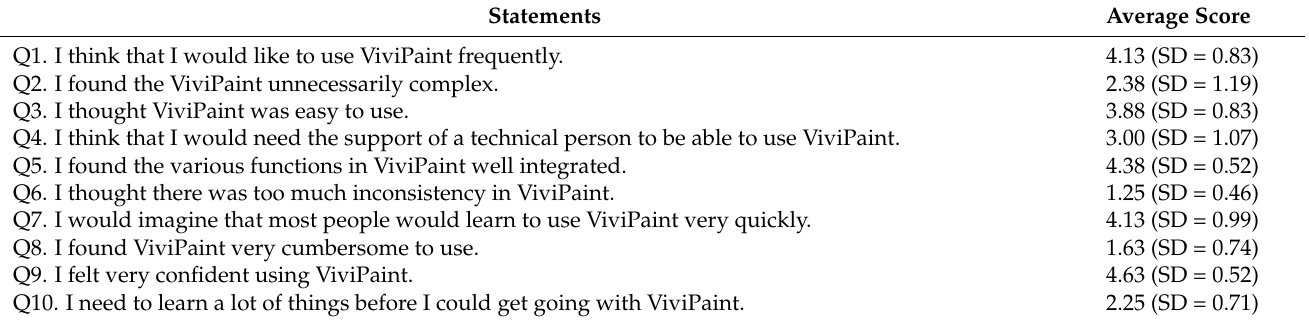
Table 1. Average score of the 10 statements of the SUS questionnaire. Note that Q2,4,6,8,10 highlighted in gray are negative questions, so we reversed the score when calculating the overall